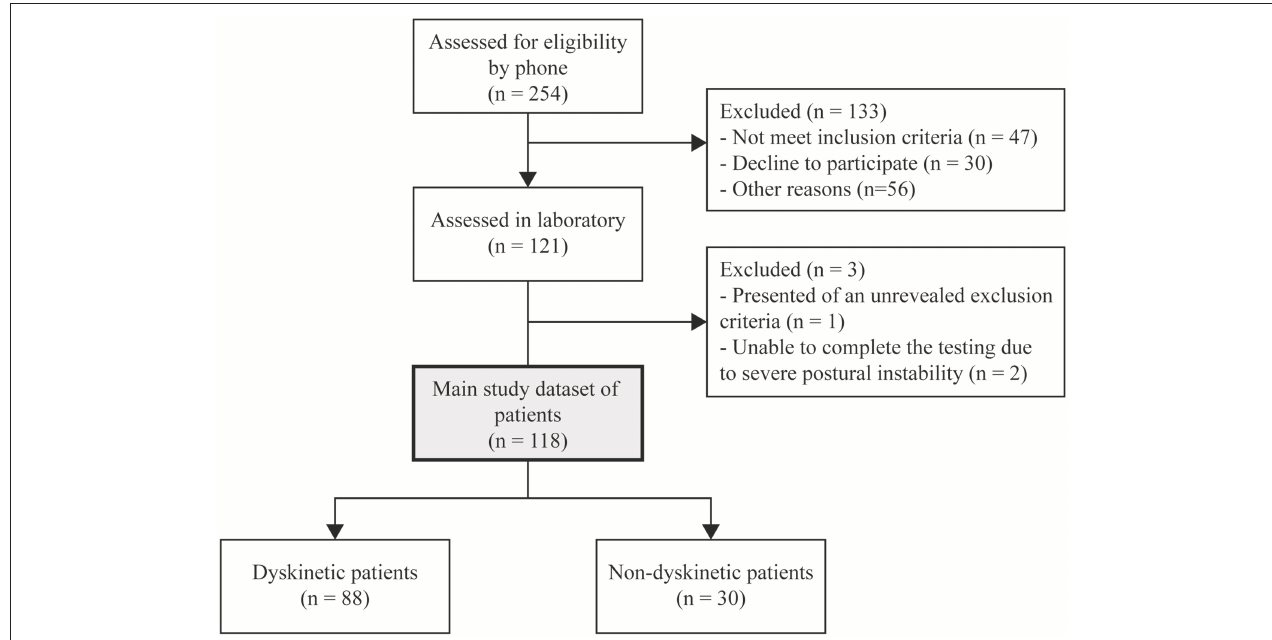
FIGURE 2 | Flowchart of the inclusion of